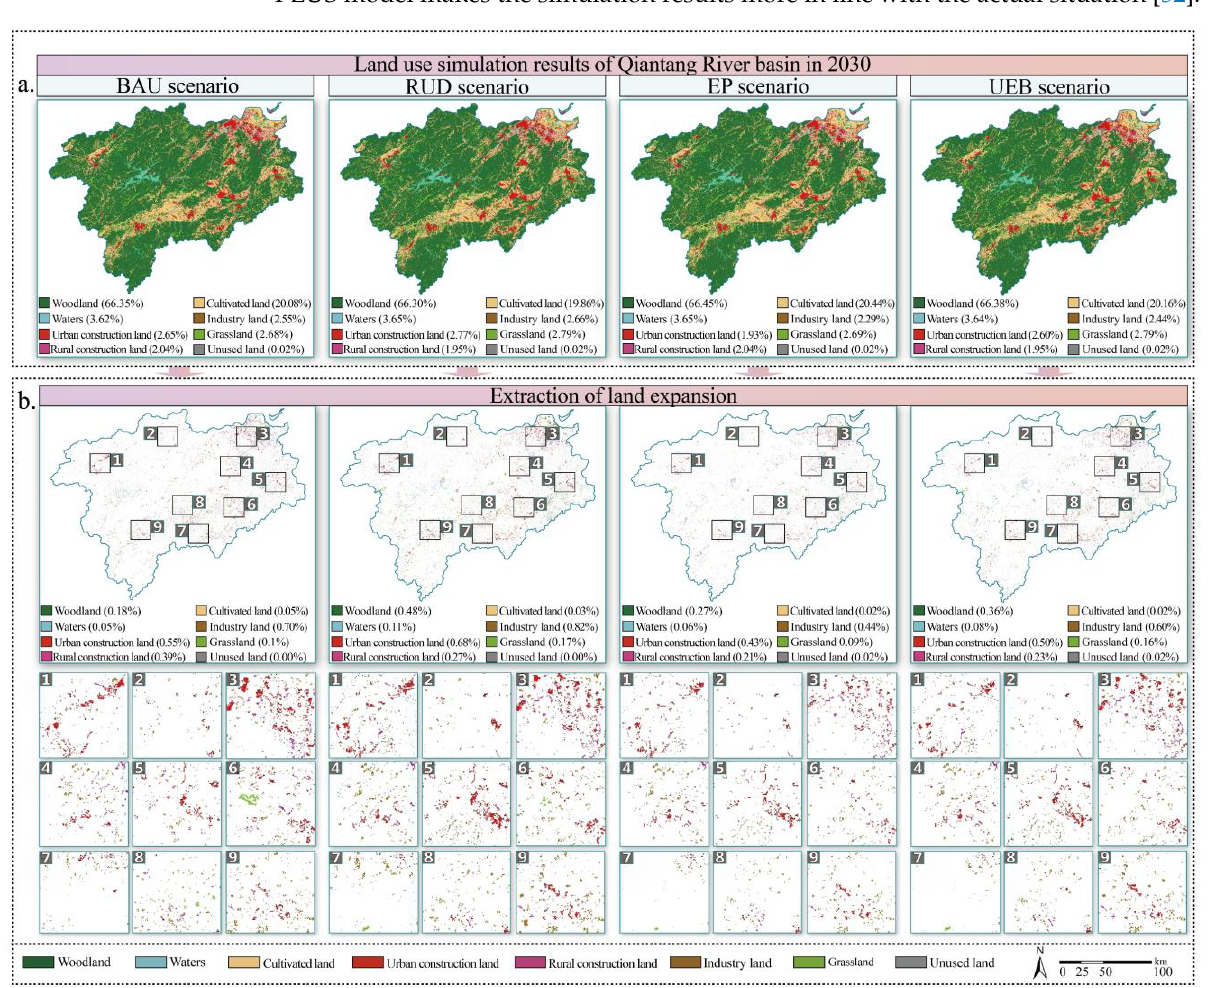
Figure 8. The results of the multi scenario simulation ( a ) and the analysis of the expansion region ( b ). Table 3. LULCCs in each scenario in 2030 (compared with